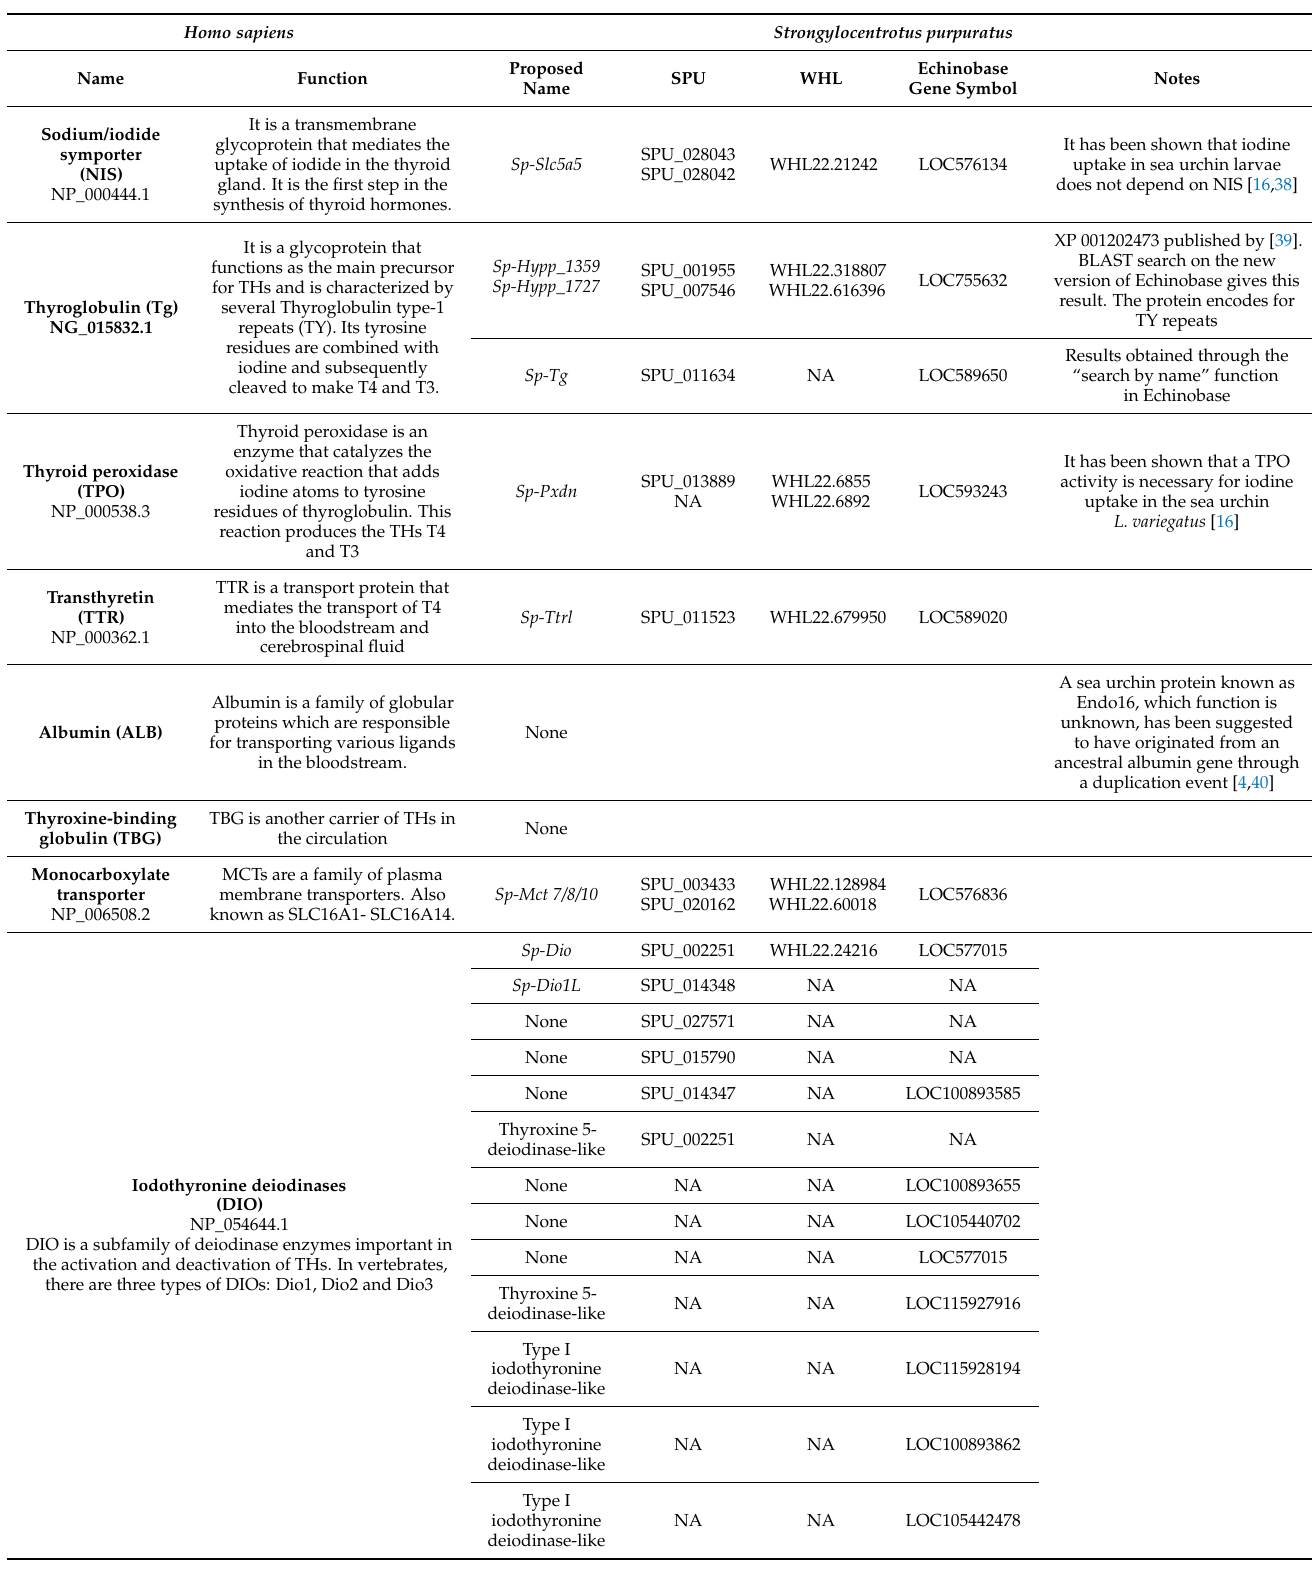
Table 1. Molecular components of the THs pathway in humans and S. purpuratus . Summary of vertebrate genes involved in the TH pathway, including a brief description of their function and homologs identified in the sea urchin genome, the proposed names, and their IDs in the old and new Echinobase versions. Notes on available literature are